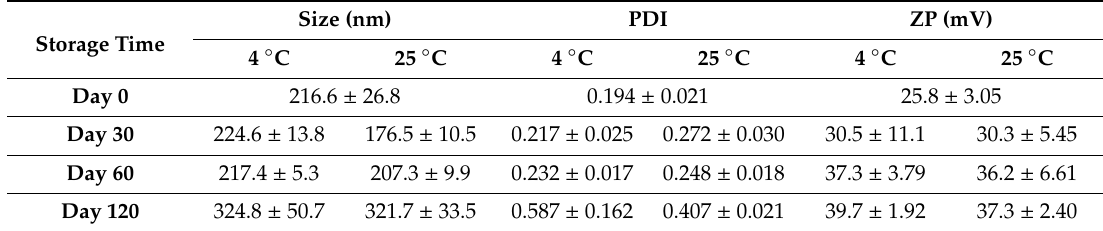
Table 6. E ff ect of storage on particle size, PDI, and ZP of 10 mg loaded CSNPs for 30, 60 and 120 days at 4 ◦ C and 25 ◦